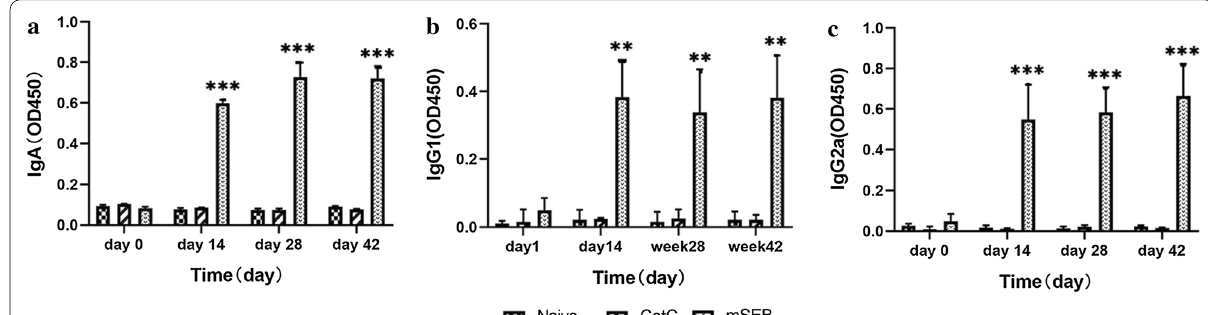
Fig. 5 Detection of SEB-specific antibodies in mice after oral administration with spores. SEB-specific antibodies level from mice intragastrically gavage with PBS (naïve group), CotC spores (CotC group), and mSEB spores (mSEB group) at day 0, 14, 28, and 42. Results are presented as mean values and standard deviations (SD) a Fecal SEB-specific IgA level, b serum SEB-specific IgG1 level, c serum SEB-specific IgG2a level. * p < 0.05, ** p < 0.01, *** p < 0.001